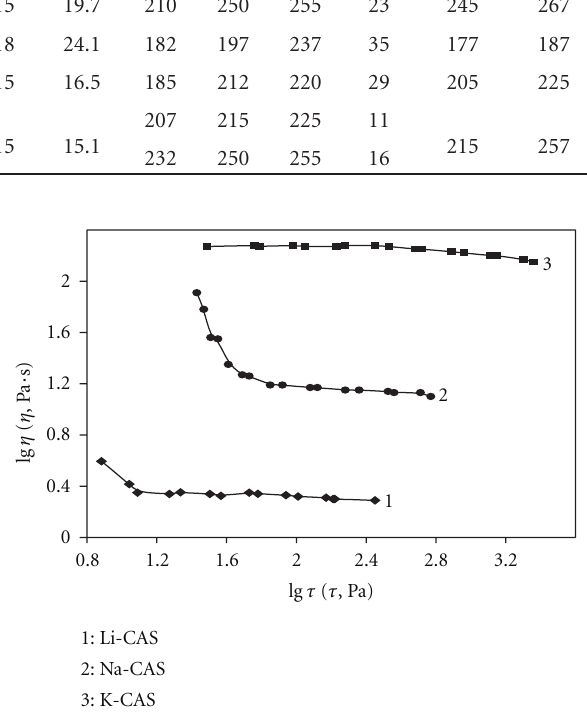
Figure 7: Plot of the viscosity of 52 wt.% aqueous CAS salts solutions versus shear stress ( T = 20 ◦